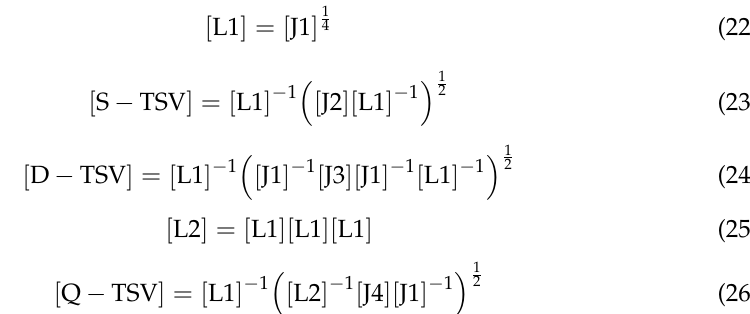
The number of frequency points of the high-frequency measurement is marked